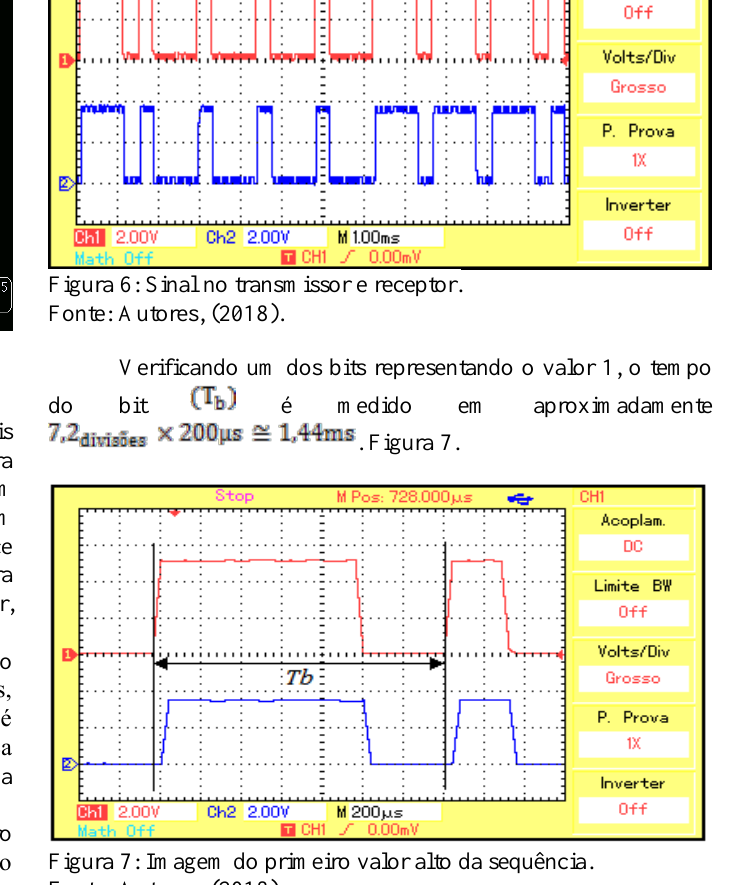
Figura 8 é visto a imagem do primeiro valor baixo da sequência.